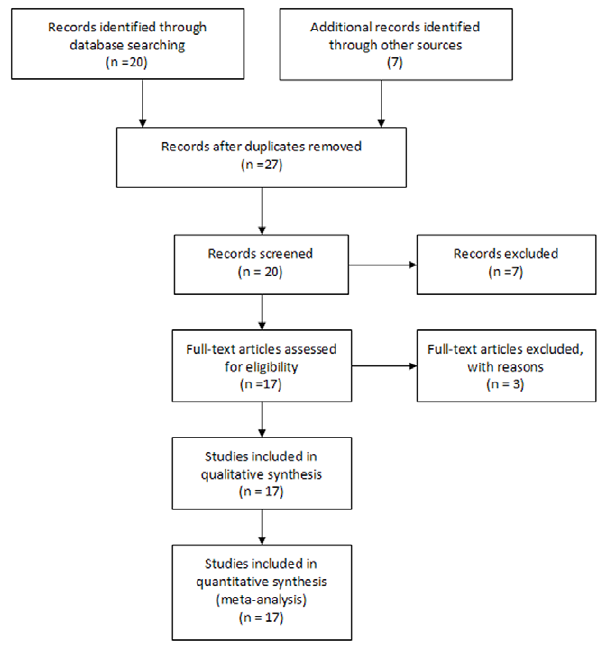
Figure 1. Flow diagram of studies identification.